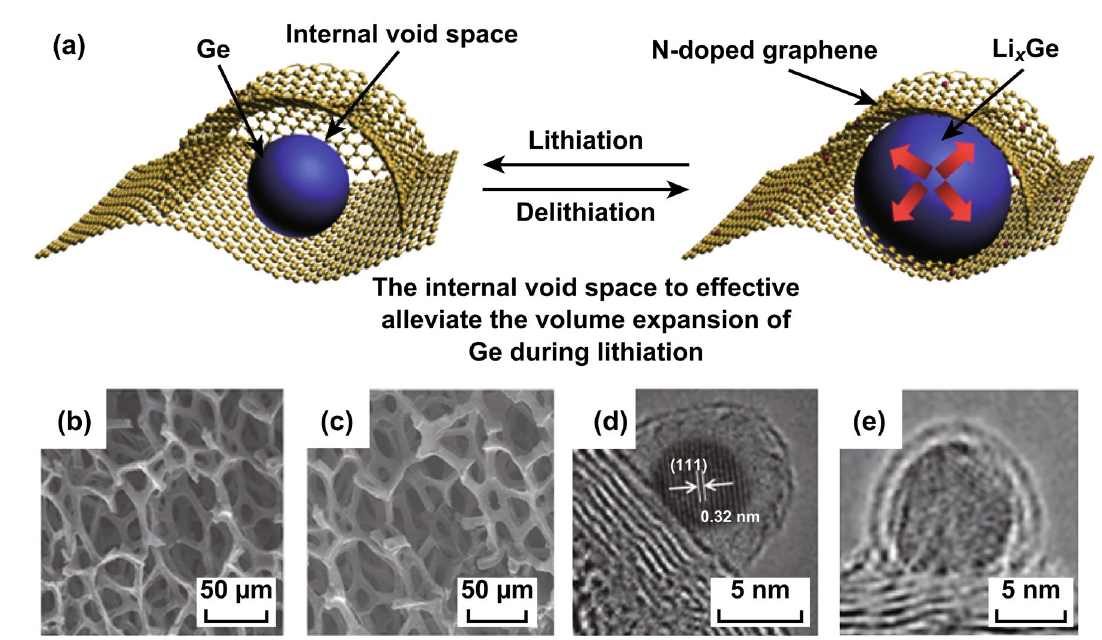
Fig. 6 a Schematic of the lithiation/delithiation processes of the Ge‑QD@NG/NGF/PDMS yolk‑shell electrode. b , c SEM and d , e TEM images before cycling and under lithiation after 1000 cycles at a current density of 1 C. Reprinted with permission from Ref.